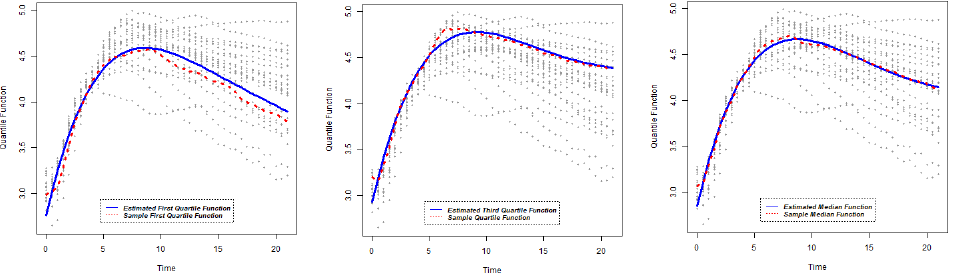
Figure 17. Quantile functions and sample quantile functions of PA2975(rluc)(B3): lower quartile ( left ); median ( center ); upper quartile ( right